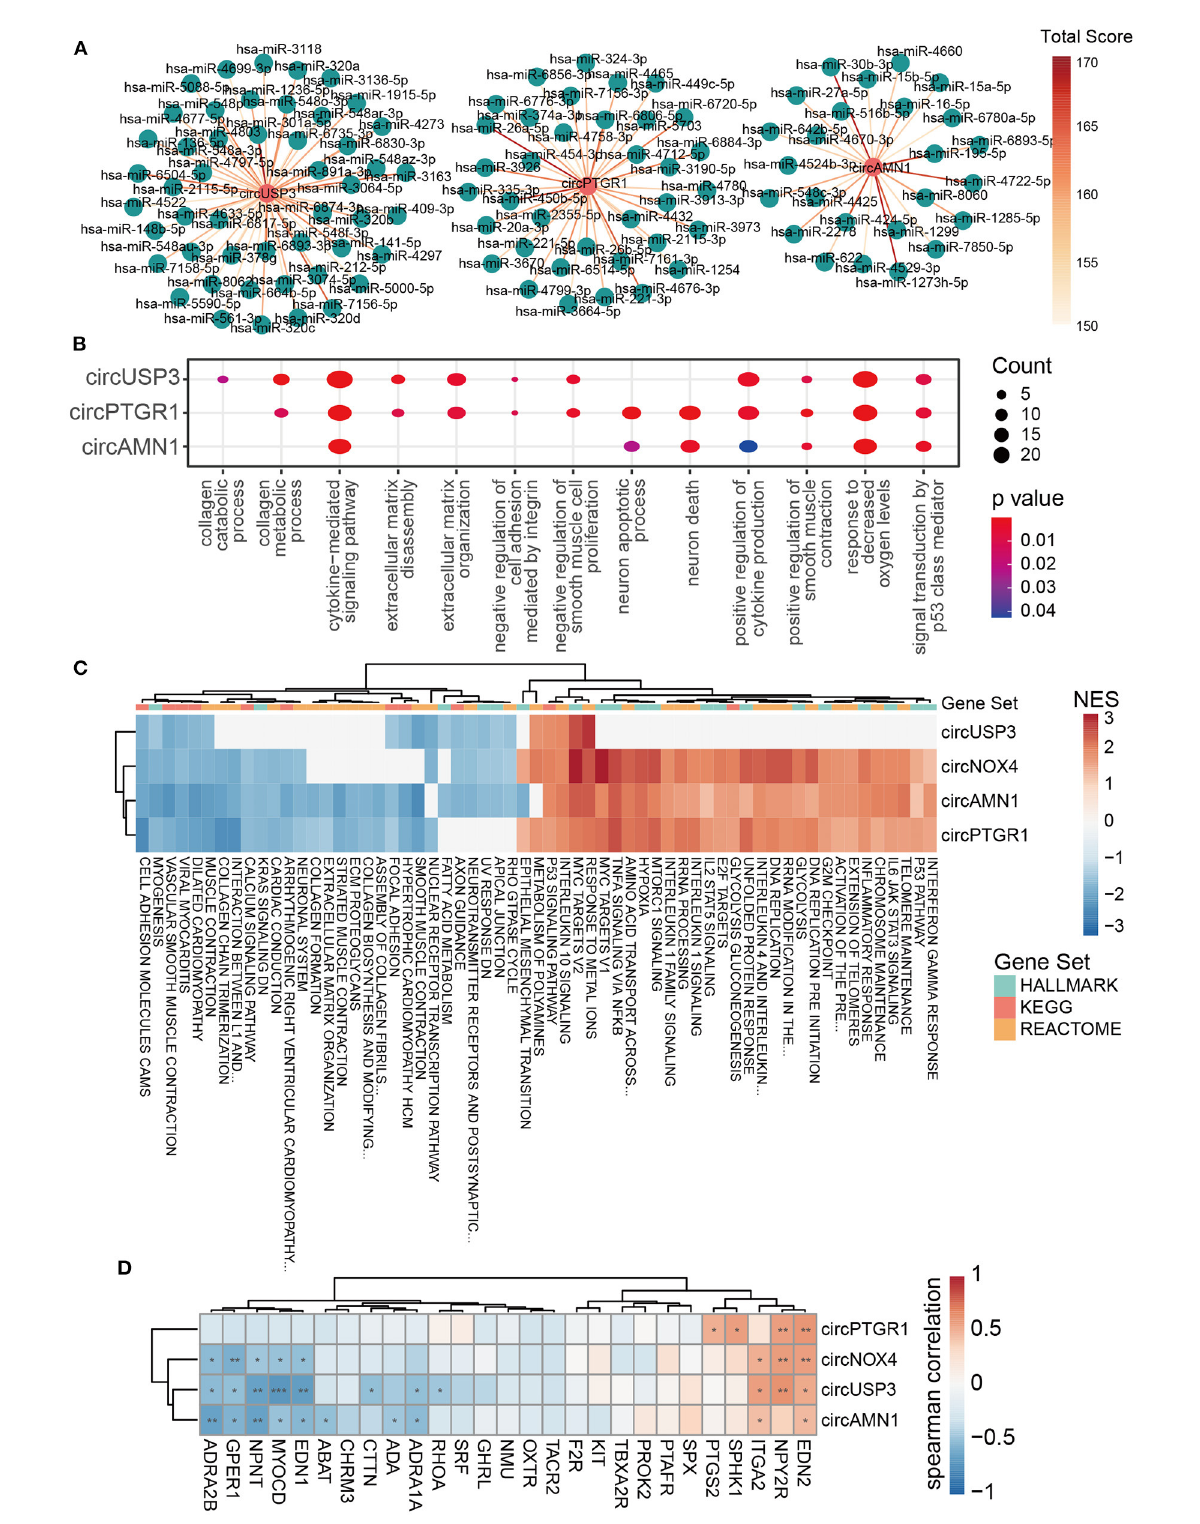
FIGURE4 The key circRNAs of TAAD were functional in inflammation, ECM remodeling, and VSMC dysfunction. (A) CircRNA–miRNA interaction network predicted by circBank. The higher the total score means the greater probability that the predicted miRNA is a real one. (B) Dot plot